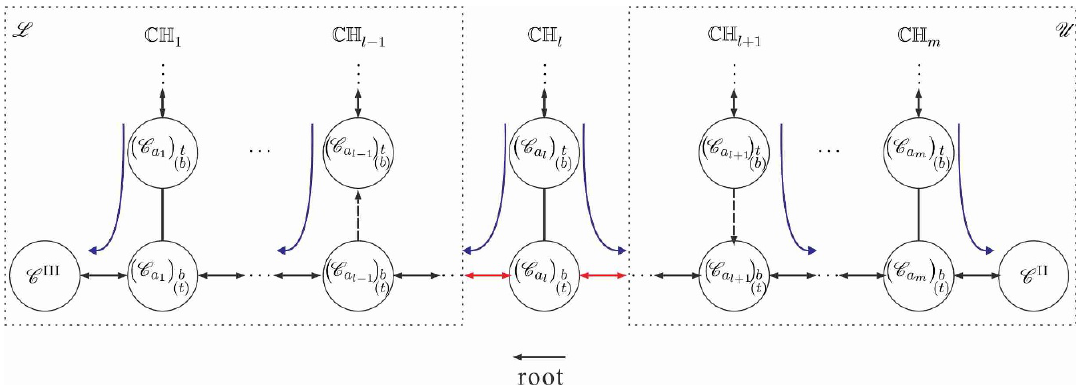
Figure 17 . A typical spurious graph where the path starting from the highest-weight ele- ment and ending at the root 1 passes through some single sides of type-I (IA or IB)